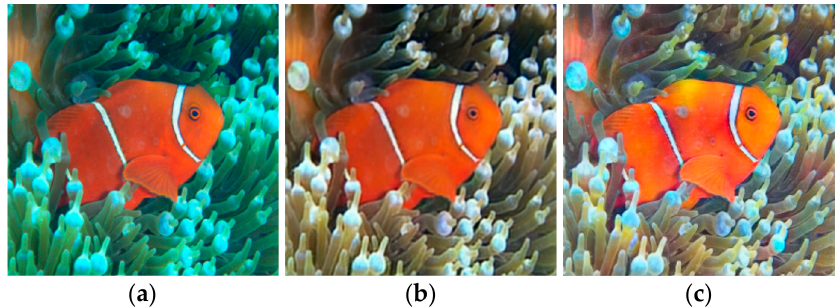
Figure 7. One example presented by Hashisho et al. ( a ) is the input image, ( b ) the result produced by UGAN and ( c ) the result produced by UDAE. Images from